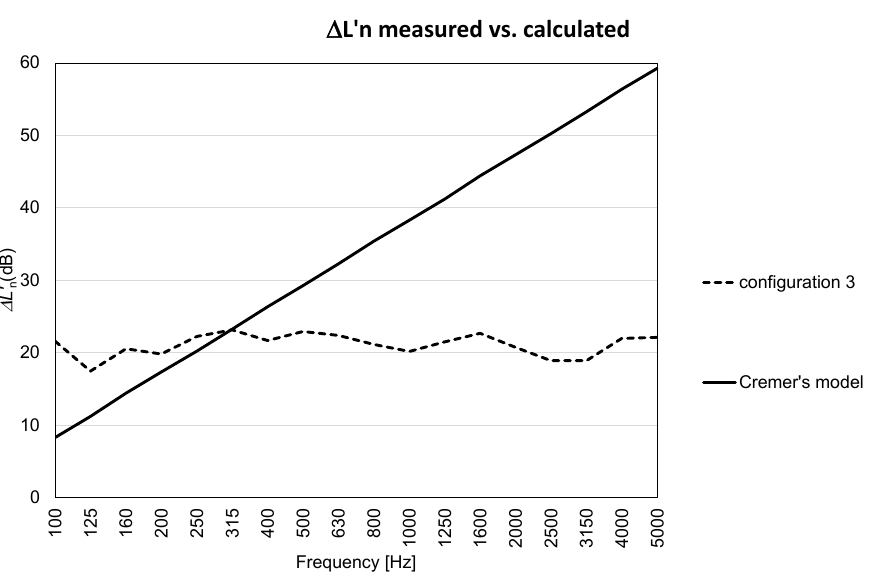
Figure 11. Comparison between Cremer’s and measured ∆ L (cid:48) n,w for configuration 3.